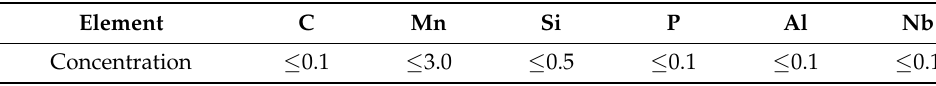
Table 1. Chemical composition of selected steel (SPFH590) (wt%).